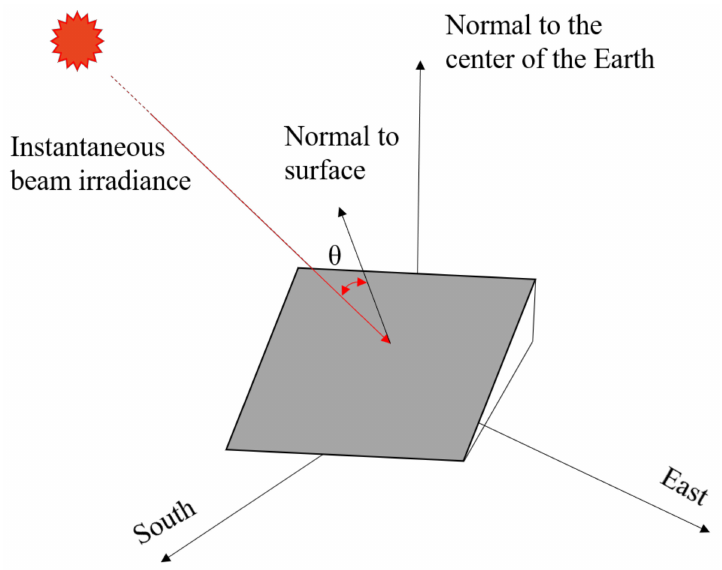
Figure 2. Relationship between the normal of the face and the instantaneous beam